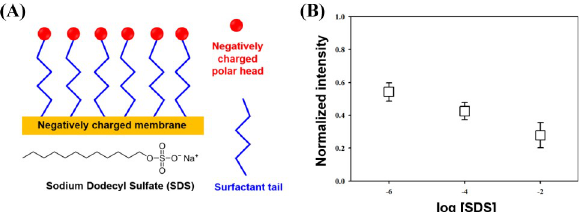
Fig 5. Effect of ionic surfactant on normalized intensity. (A) A schematic of SDS molecules adsorption on the negatively charged membrane surface. (B) Variation in normalized fluorescent intensity according to SDS